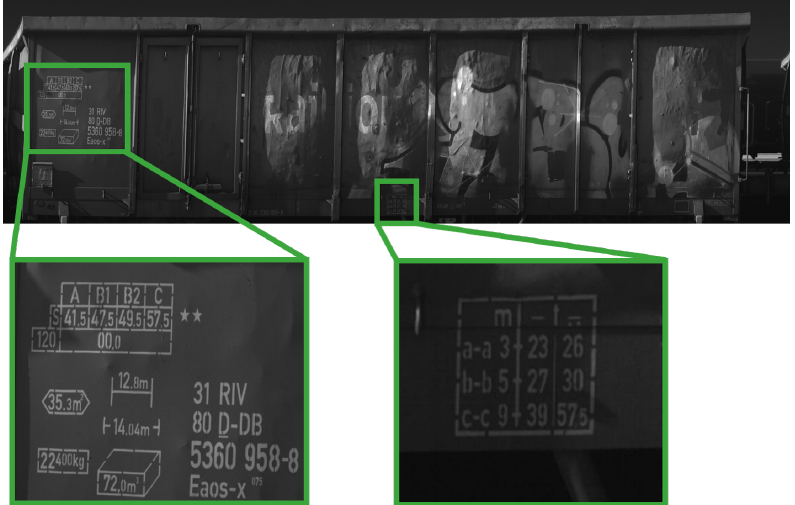
Figure 7. Side view image with character recognition examples.